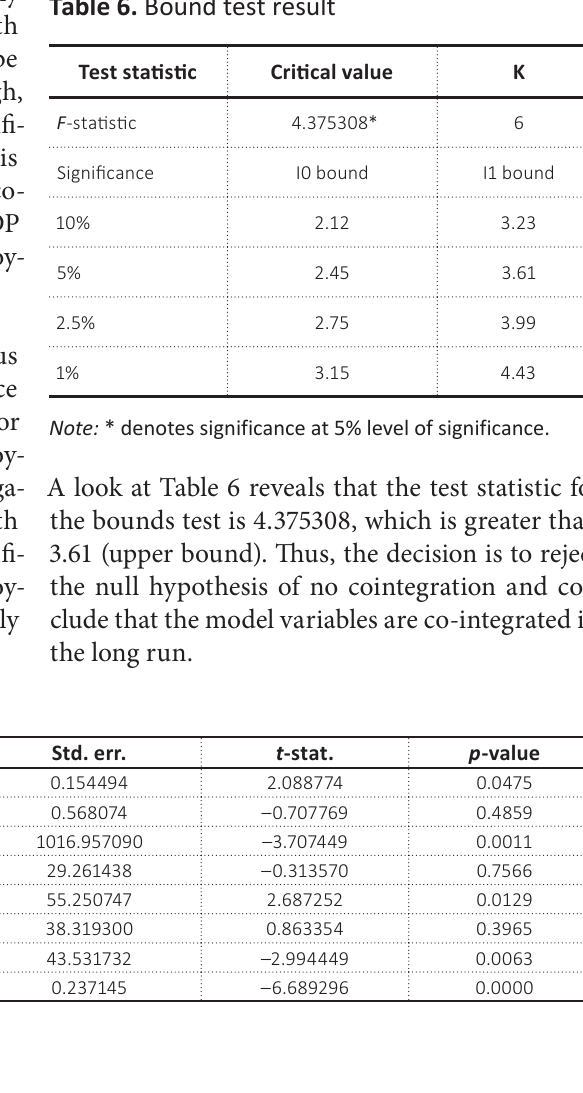
Table 6. Bound test result